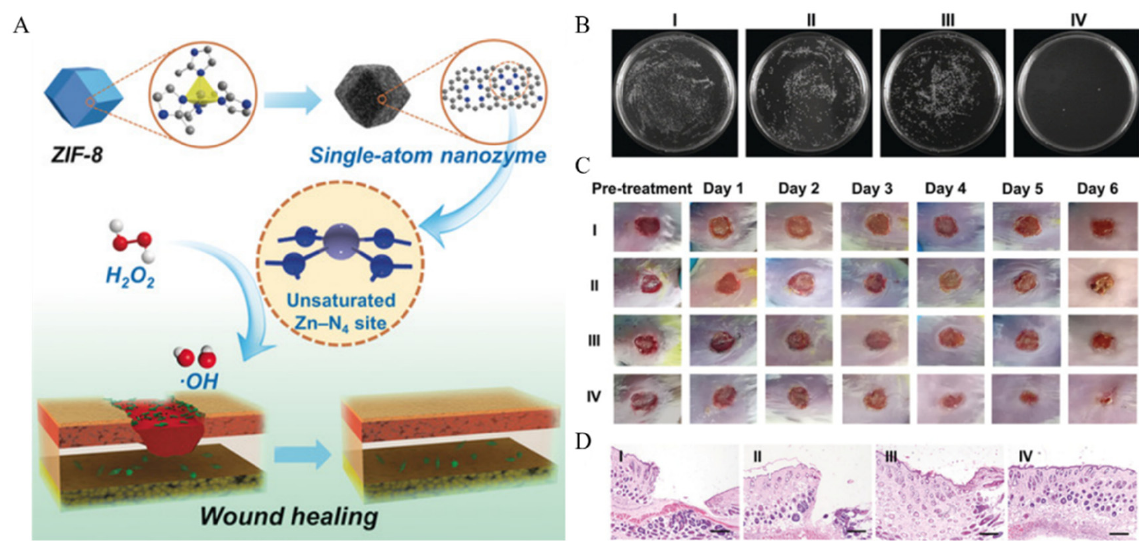
Figure 9. ( A ) Preparation of PMCS. ( B ) Antibacterial properties of PMSC. ( C ) Abilities of PMCS to promote wound healing. ( D ) Histologic analysis of the wounds (I: NaAc buffer, II: NaAc buffer + H 2 O 2, III: PMCS, and IV: PMCS + H 2 O 2 ) [47]. Copyright 2019, Wiley-VCH.